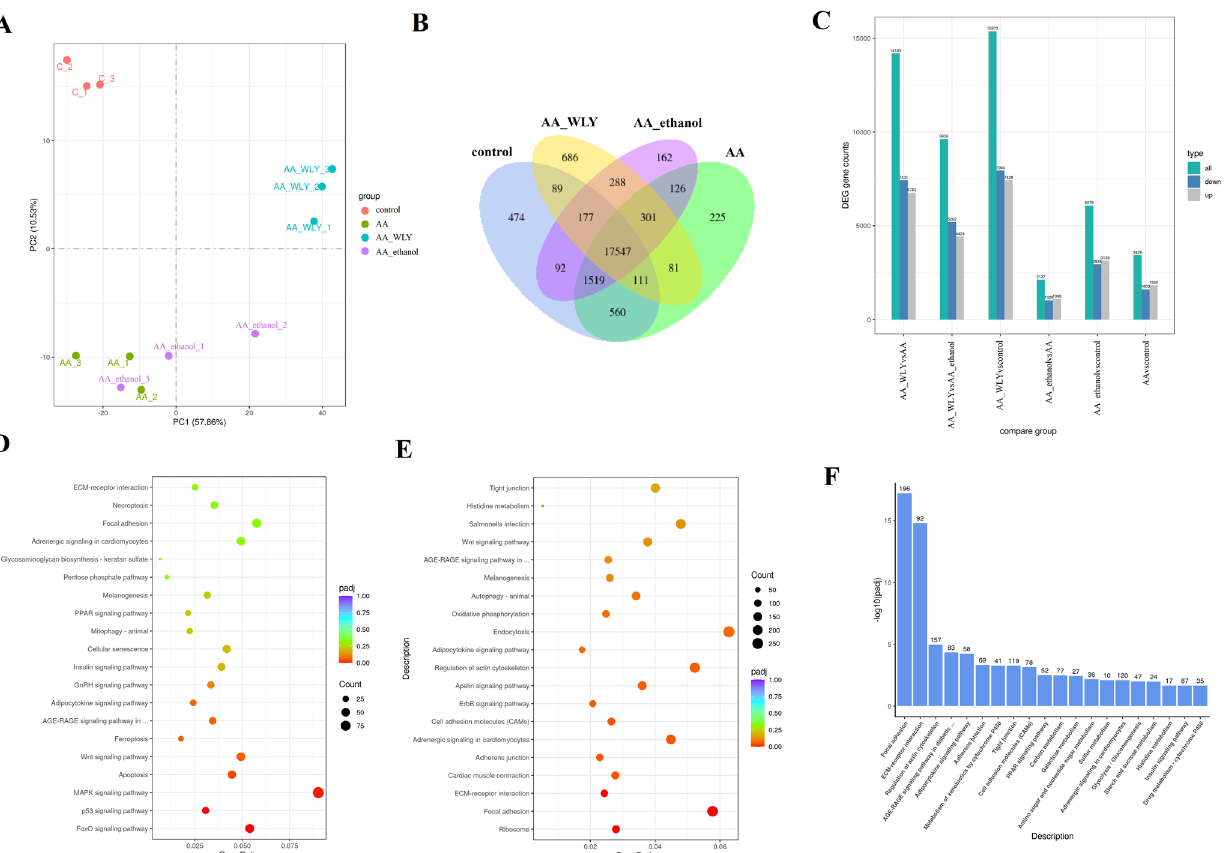
Fig. 3 RNA-seq data analysis. A PCA of gene expression. B Venn diagram of gene counts expressed. C Signi fi cant DEG counts. D The KEGG pathway enrichment of DEGs between AA and control. E The KEGG pathway enrichment of DEGs between AA and AA-Wuliangye. F Pathway Enrichment Analysis of downregulated DEGs between AA and AA-Wuliangye